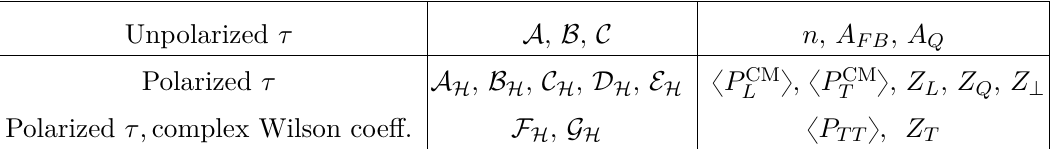
Table 1 . For each row, the observables in the second column contain the same physical informa- tion as those compiled in the third one. The quantities in the first row determine the decay for unpolarized taus, while the ones in the second and third rows describe the decays for polarized taus. Finally, observables in the third row are zero unless the Wilson coefficients are